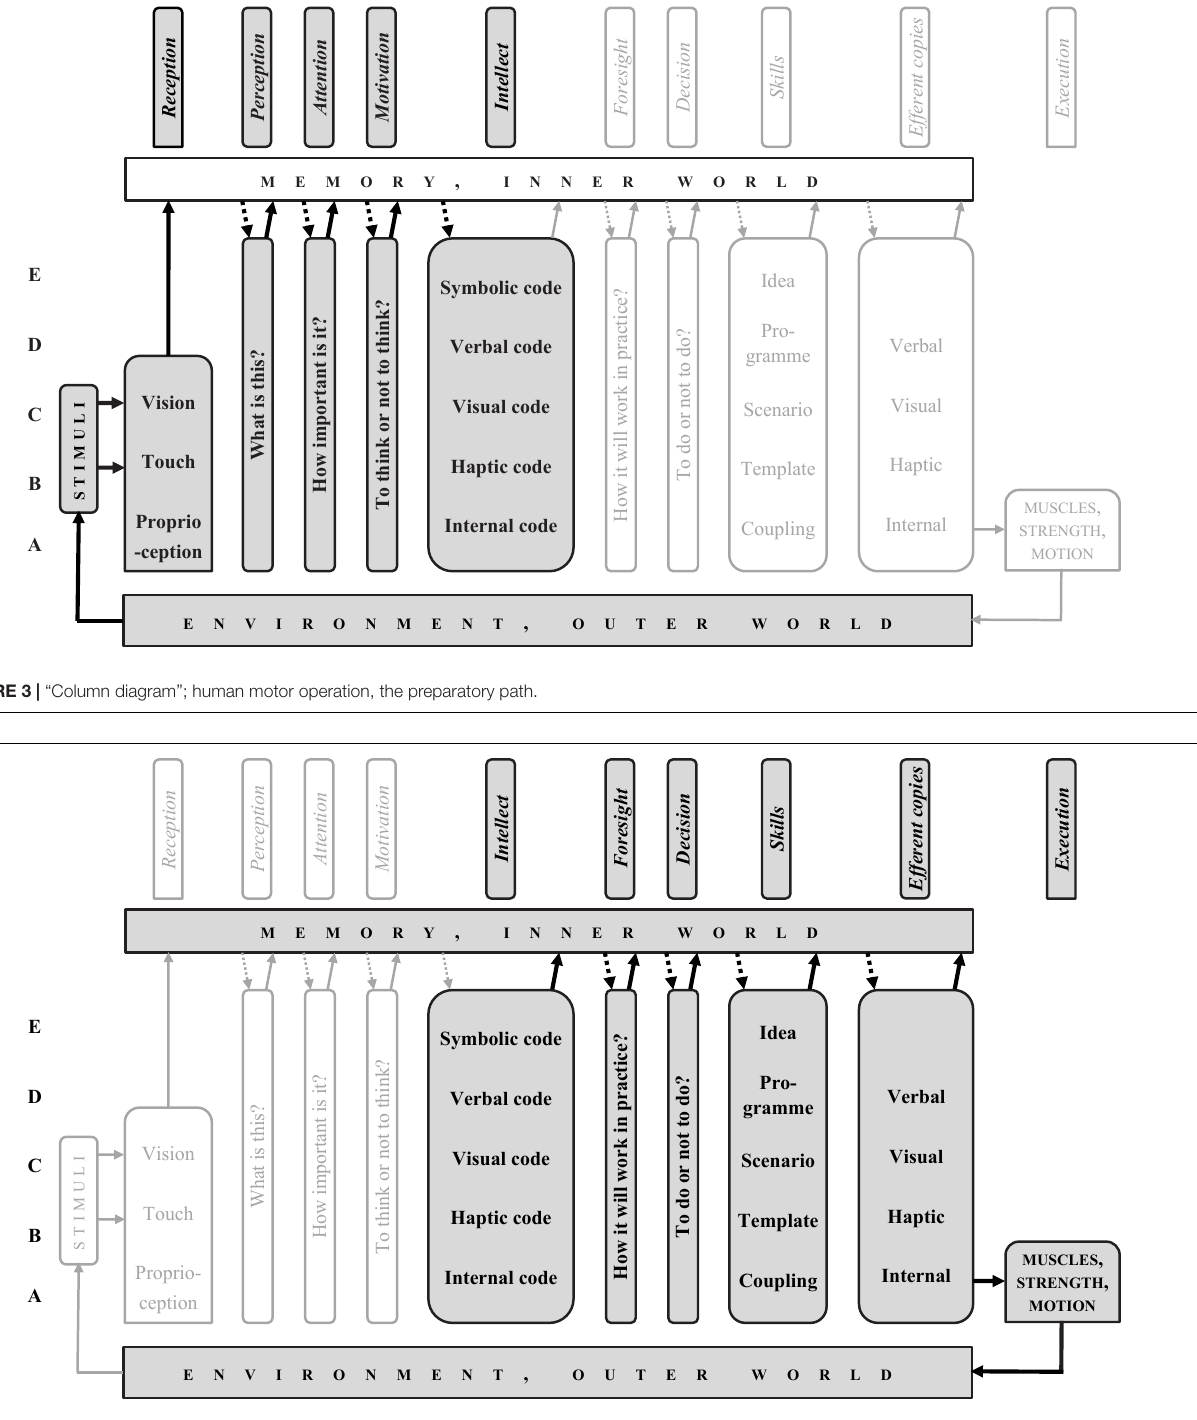
FIGURE 4 | “Column diagram”; human motor operation, the executive